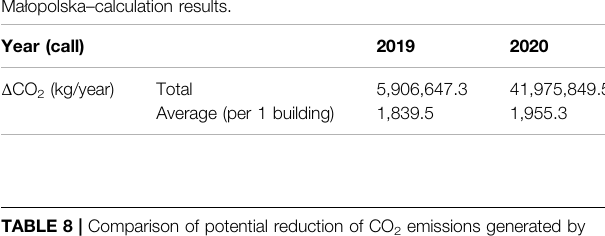
TABLE 5 | Potential annual production of electricity generated by subsidized photovoltaic microinstallations in Ma ł opolska - calculation results.